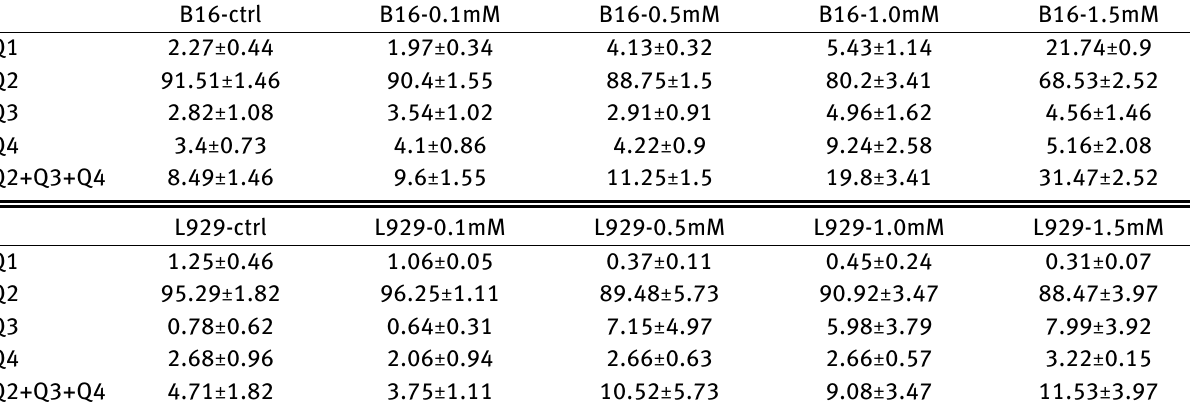
Table S1: The data of FCM-based apoptosis results. B-16 and L929 cells were treated with Yb3+ at 0, 0.1, 0.5, 1.0, 1.5mmol/L. (Mean ± SD)